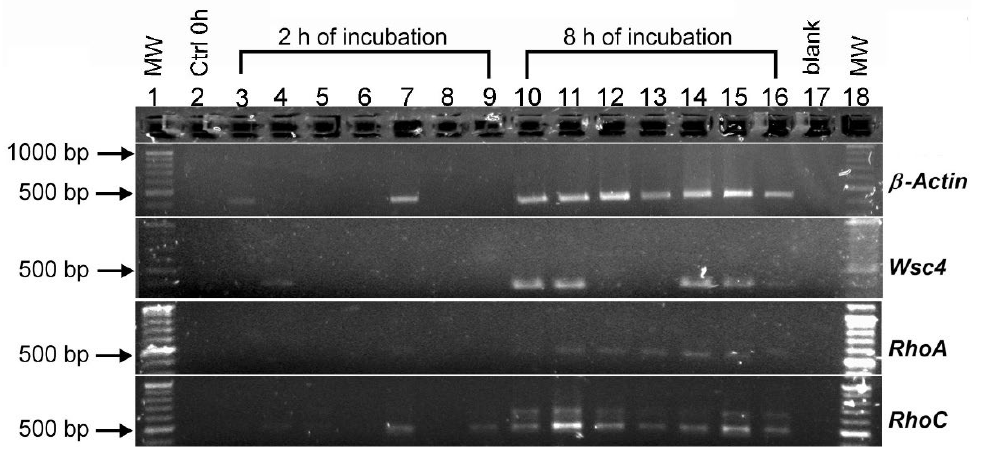
Figure 7. Agarose gel electrophoresis of PCR amplification of β -Actin, Wsc4 , RhoA and RhoC genes of Aspergillus niger conidia after exposure to underwater shock waves and 2 and 8 h of incubation.